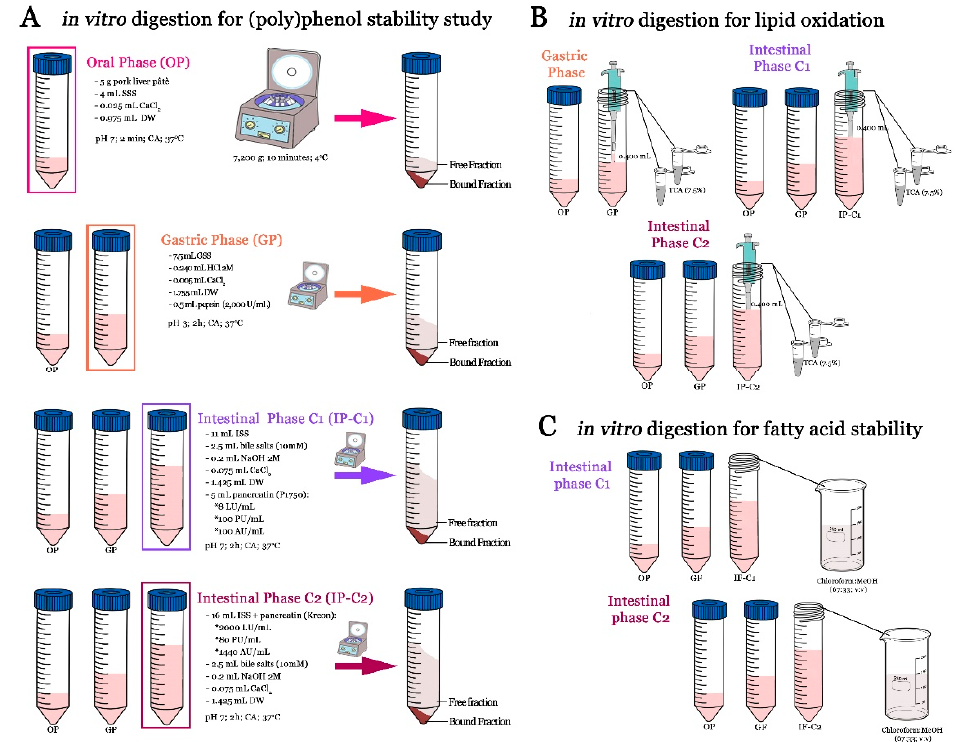
Figure 1. Schematic representation of the in vitro gastrointestinal digestion assays carried out to evaluate ( A ) polyphenol stability; ( B ) lipid oxidation; and ( C ) fatty acid stability in liver pork